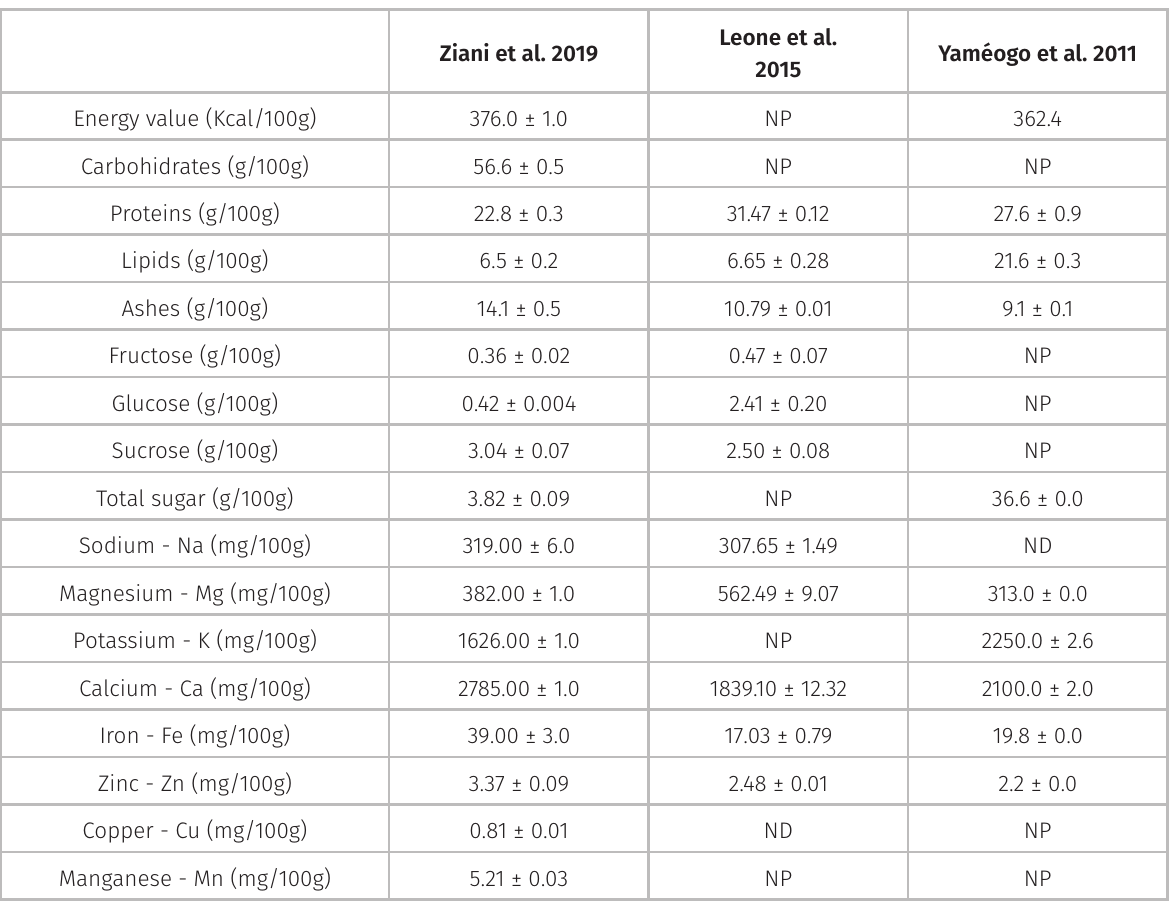
Table II. Nutritional characterization of Moringa oleifera dried leaves.